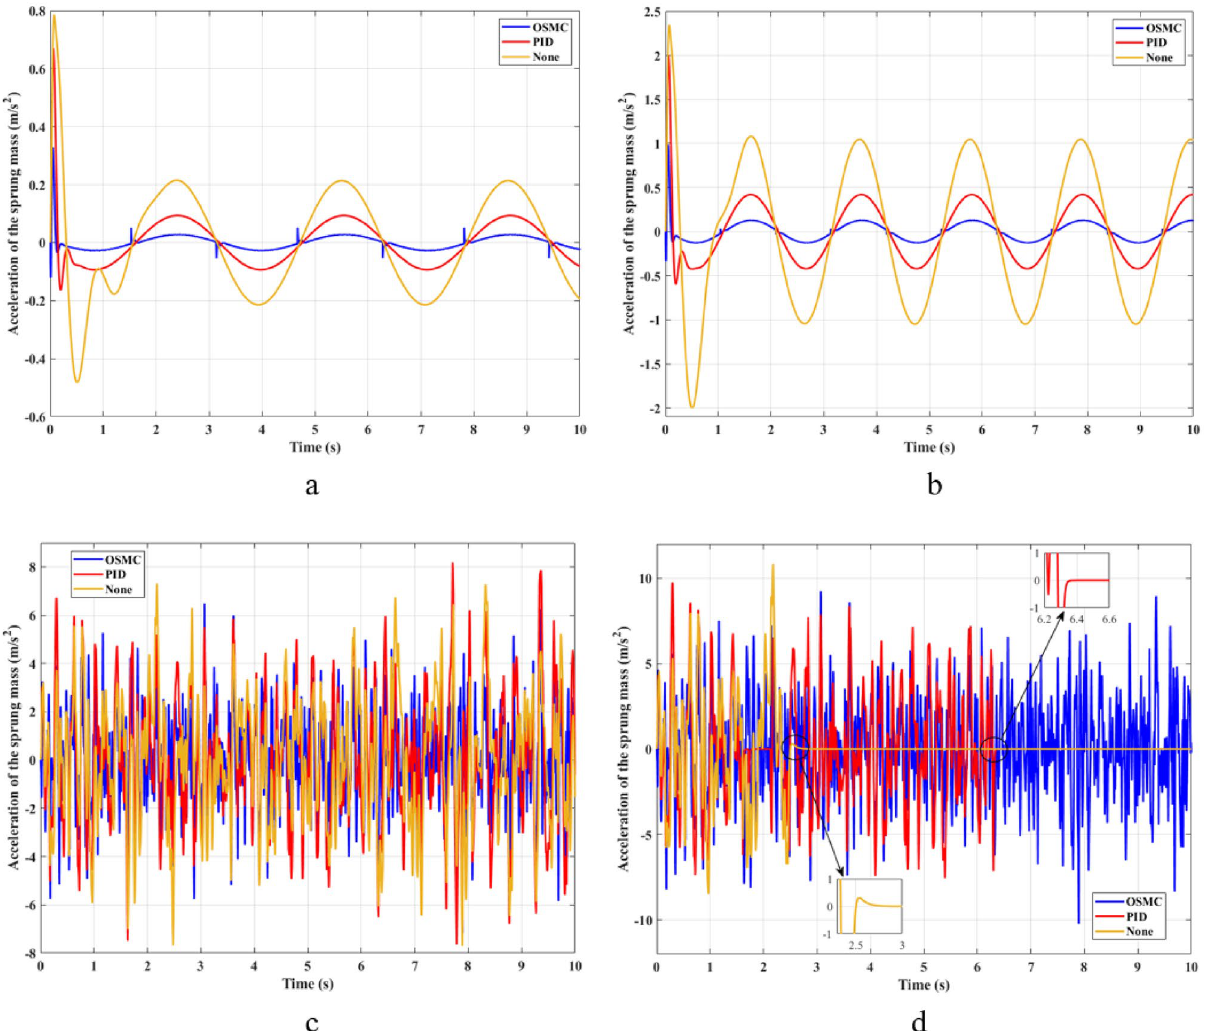
Figure 5. Acceleration of the sprung mass (( a ) Case 1; ( b ) Case 2; ( c ) Case 3; ( d ) Case oscillation have been increased. As a result, the displacement values of the vehicle body are also increased. The values obtained in the second case reach 128.05 (mm), 46.79 (mm), and 14.76 (mm) for the maximum values, respectively; 82.32 (mm), 32.97 (mm), and 10.30 (mm) for mean values. These are only cyclic excitations, so the variation of values is also cyclical. Compared with the results in Ref. 29 , which applied the SMC algorithm to the suspension, the value of vehicle body displacement obtained from this paper is much smaller. Besides, the system’s stability is also better when using the OSMC algorithm instead of the SMC algorithm. In the other two cases, random stimulation was used. Therefore, the vehicle’s oscillation will also change continuously over time. In the third case (c), body vibration can reach 100.83 (mm) if the vehicle is not equipped with an active suspension system. In contrast, the maximum value of the displacement of the sprung mass is only about 31.90 (mm) and 10.57 (mm) if the vehicle uses an active suspension system with a hydraulic actuator. The average value of oscillations in these two situations is only 34.05% and 10.60% respectively, compared with the previous situation. Vehicle instability occurs in the last case (d). According to the results of Fig. 4d, the wheel will be lifted off the road at a time t = 2.5 (s), corresponding to the situation of the vehicle using only the passive sus- pension system. Besides, instability can also occur even when the vehicle has used the active suspension system. If the PID algorithm for the SISO system is applied, this instability still occurs at time t = 6.4 (s). Meanwhile, the OSMC algorithm still helps to ensure the stable performance of the vehicle during movement. The acceleration values obtained using the OSMC algorithm are all smaller than the conventional SMC algorithm 28,29 . Therefore, the smoothness of the car is better. The acceleration of the sprung mass is considered to evaluate the smoothness when traveling on the road. The change in the acceleration of the sprung mass is shown in Fig. 5. In the first two cases, the acceleration is maximal at the first instant. Their maximum values corresponding to the three situations examined are: 0.79 (m/s 2 ), 0.67 (m/s 2 ), and 0.33 (m/s 2 ) for the first case; 0.82 (m/s 2 ), 0.34 (m/s 2 ), and 0.11 (m/s 2 ) for the second case. After the first phase of the oscillation, the acceleration value of the vehicle body will gradually decrease and change periodically with time. Their average values are, respectively, 0.29 (m/s 2 ), 0.30 (m/s 2 ), and 0.07 (m/